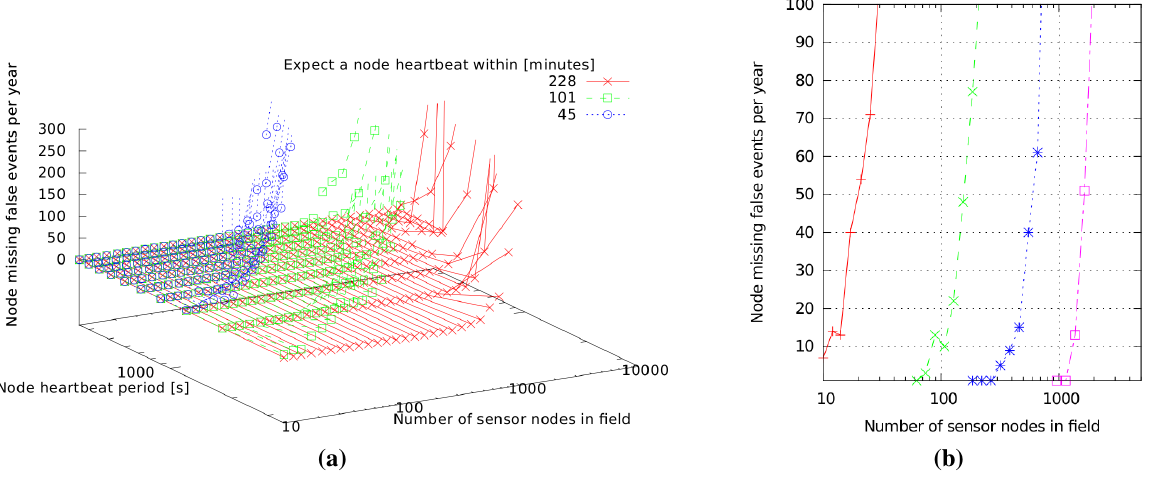
Figure 2. Simulation results of the field communication protocol for design space exploration. The rate of the missing node erroneous reportsincreases with the number of nodes and with the heartbeat period and lowers with the increase of the heartbeat listening window of the gateway ( a ); missing nodes can be detected in less than 6 h with a negligible rate of erroneous reports, for a 1 h heartbeat period ( b